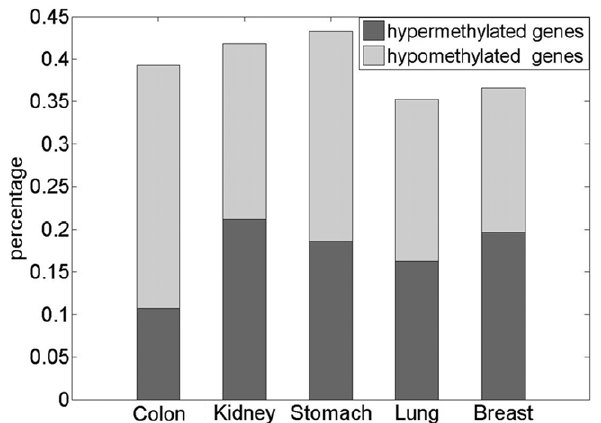
Figure 1. Distributions of DM genes in the five datasets. This figure illustrates the number of DM genes in the datasets for all five cancer types. The x-axis denotes the cancer type, and the y-axis denotes the percentage of DM genes in all detected genes. The light grey and dark grey areas represent hypomethylated and hypermethylated genes,